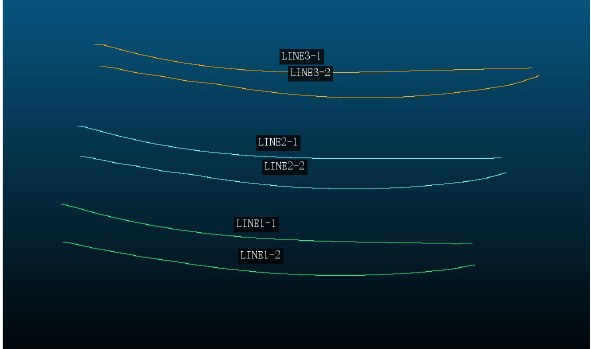
Figure 11. Reconstructed power lines